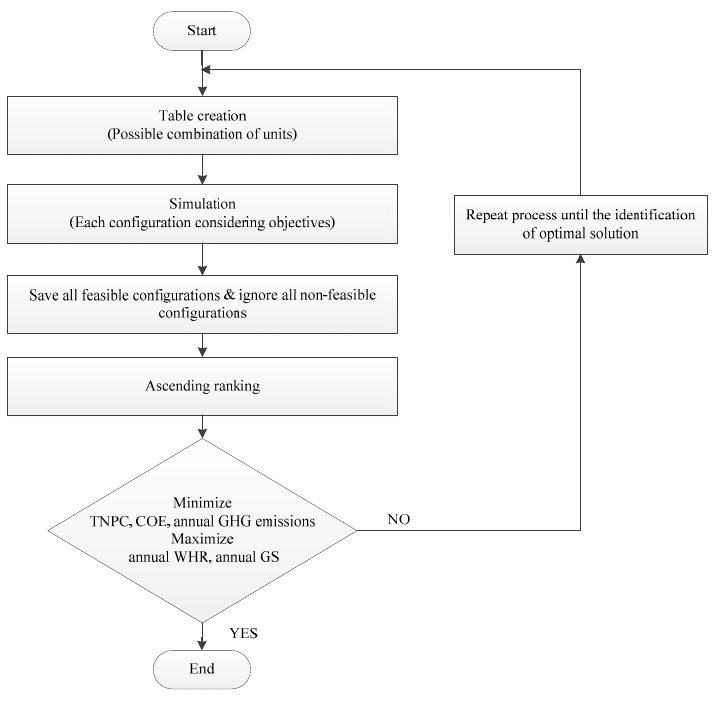
Figure 9. Homer Pro flow chart.